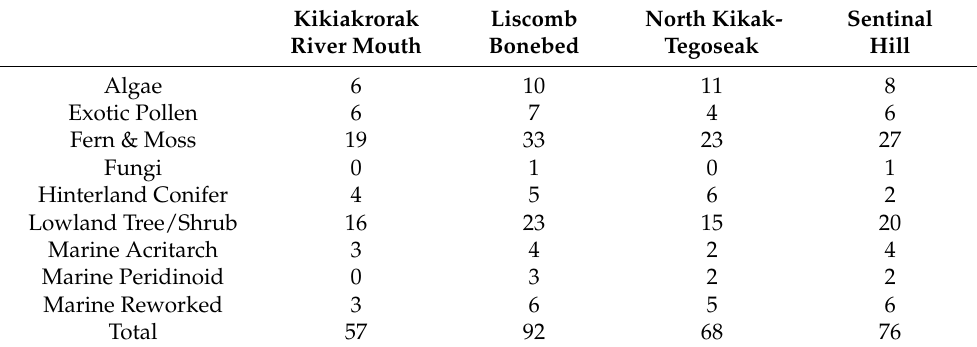
Table 6. Raw taxonomic richness (number of genera) at each locality.